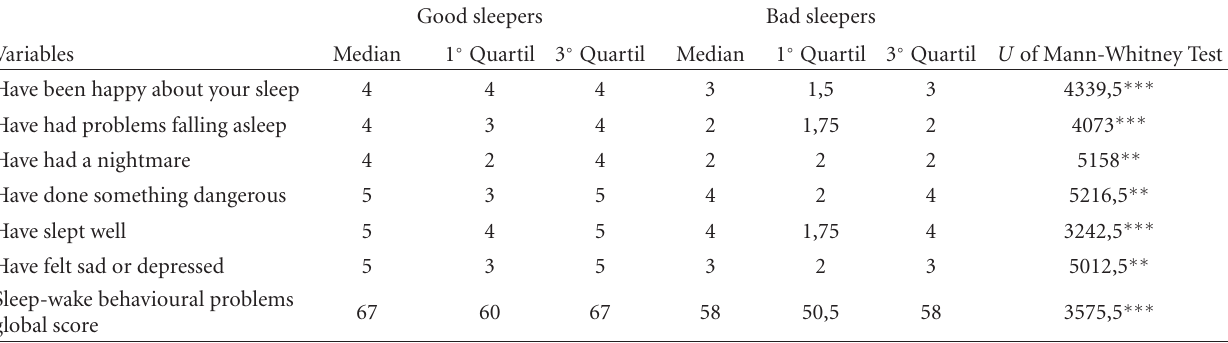
Table 3: Comparison of sleep-wake behavioural problems between good and bad sleepers. Good